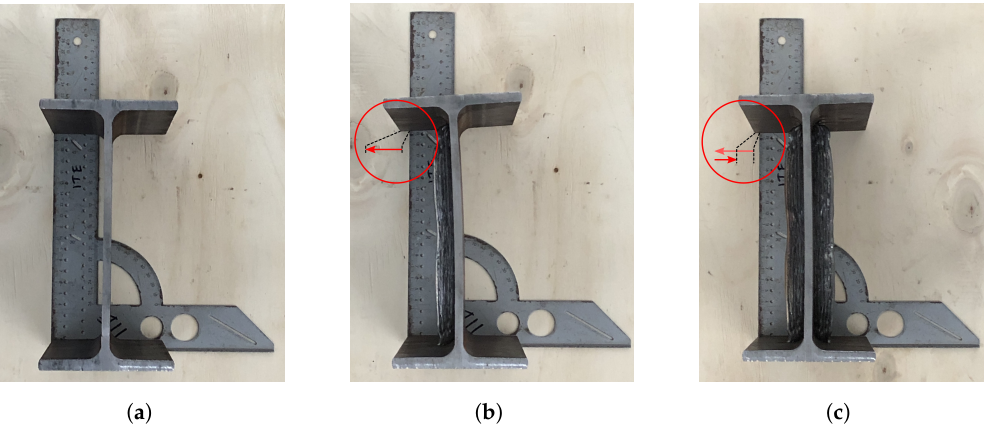
Figure 21. Deformation in cases of successively produced ribs (12 layers each): ( a ) Before; ( b ) First rib; ( c ) Second rib.